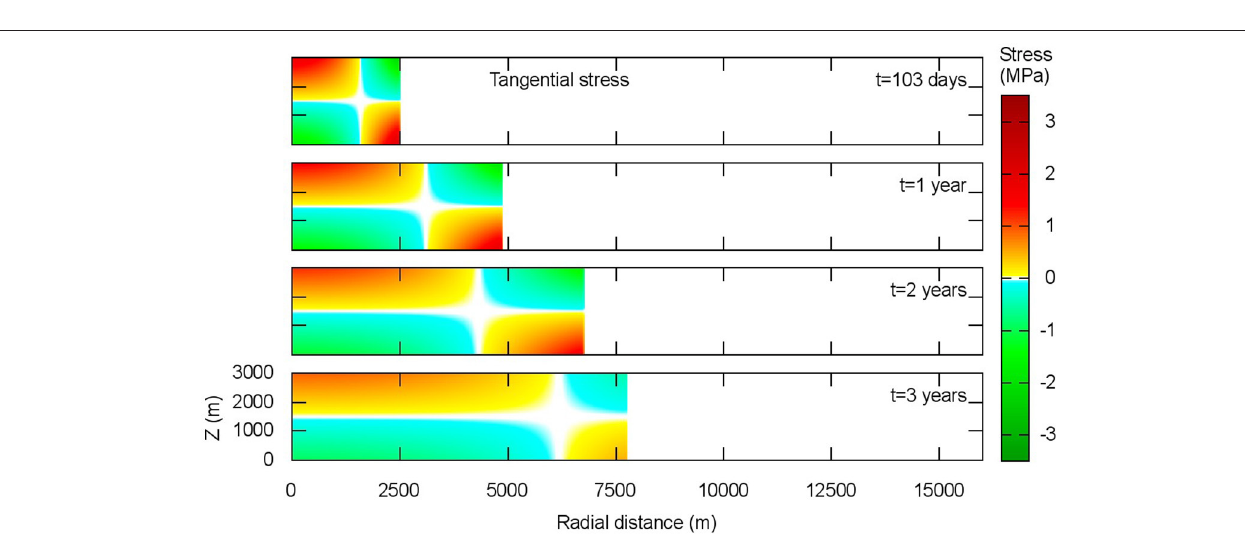
FIGURE 10 | The distribution of the tangential stress ( σ θθ ) in the elastic plate at four different times (103 days, 1 year, 2 years, and 3 years). Red indicates traction and green indicates compression.